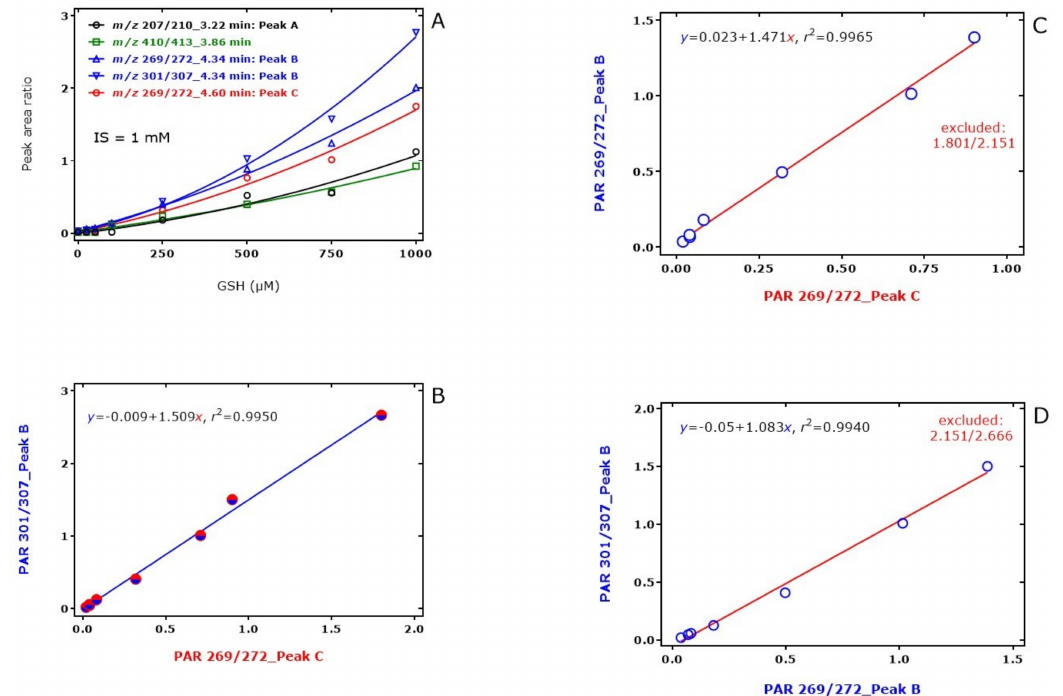
Figure 6. ( A ) Peak area ratio values for the GC-MS peaks A, B and C, formed from derivatized GSH (0–1000 µ M) using 1 mM d 6 -GSH as internal standard (IS). ( B ) Linear regression analysis between the peak area ratio (PAR) of m / z 301 to m / z 307 for peak B, and of the PAR m / z 269 to m / z 272 for peak C. ( C ) Linear regression analysis between the PAR of m / z 269 to m / z 272 for peak B, and the PAR of m / z 269 to m / z 272 for peak C. ( D ) Linear regression analysis between PAR of m / z 301 to m / z 307 for peak B, and the PAR of m / z 269 to m / z 272 for peak B with the concentration of glutathione (GSH) in the range 0–1000 µ M. Note the two excluded values in ( C , D ). Oven temperature program TP#1 was used. Peaks A, B and C refer to Figure